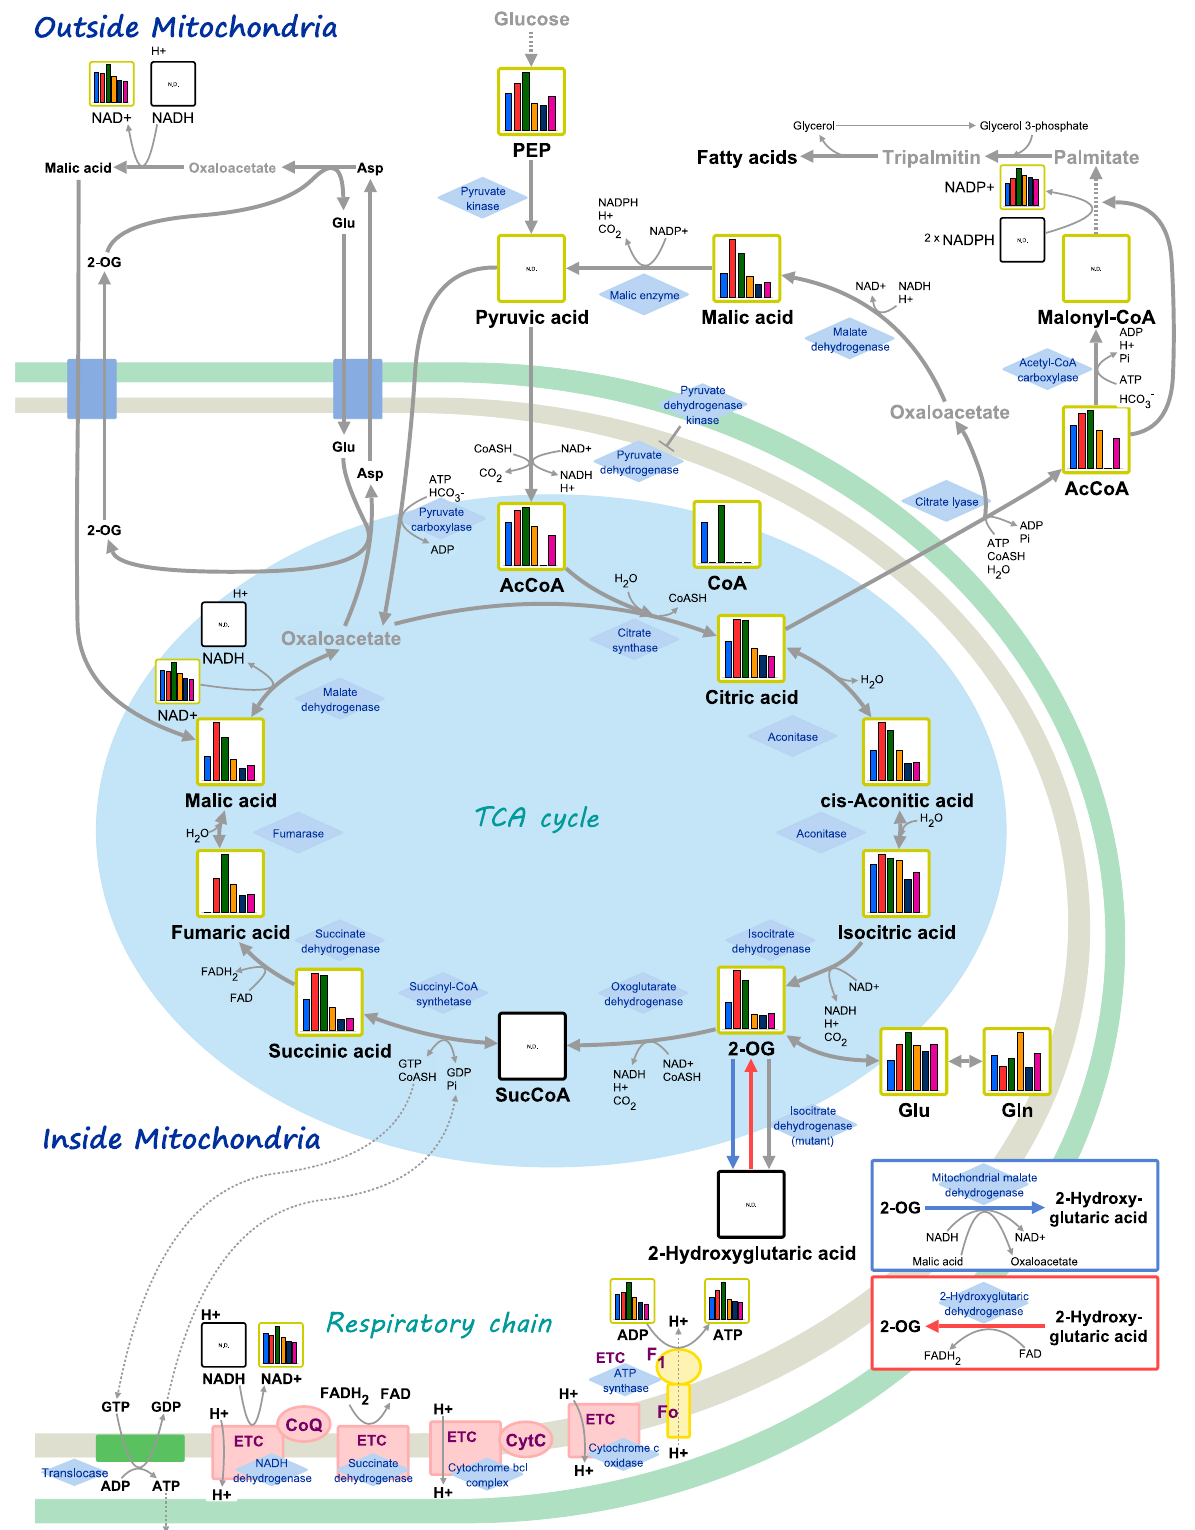
Figure 8. Location of substances detected in this study in the metabolic pathway. Substances were detected by comparison with metabolites registered in the HMT metabolite library. Graph shows the relative area values in mock-inoculated control (blue), plants inoculated with strain 4 (red), plants inoculated with strain 2 (green), mock-inoculated control plants under saline conditions (orange), plants inoculated with strain 4 under saline conditions (dark blue), and plants inoculated with strain 2 under saline conditions (purple). N.D: not detected.